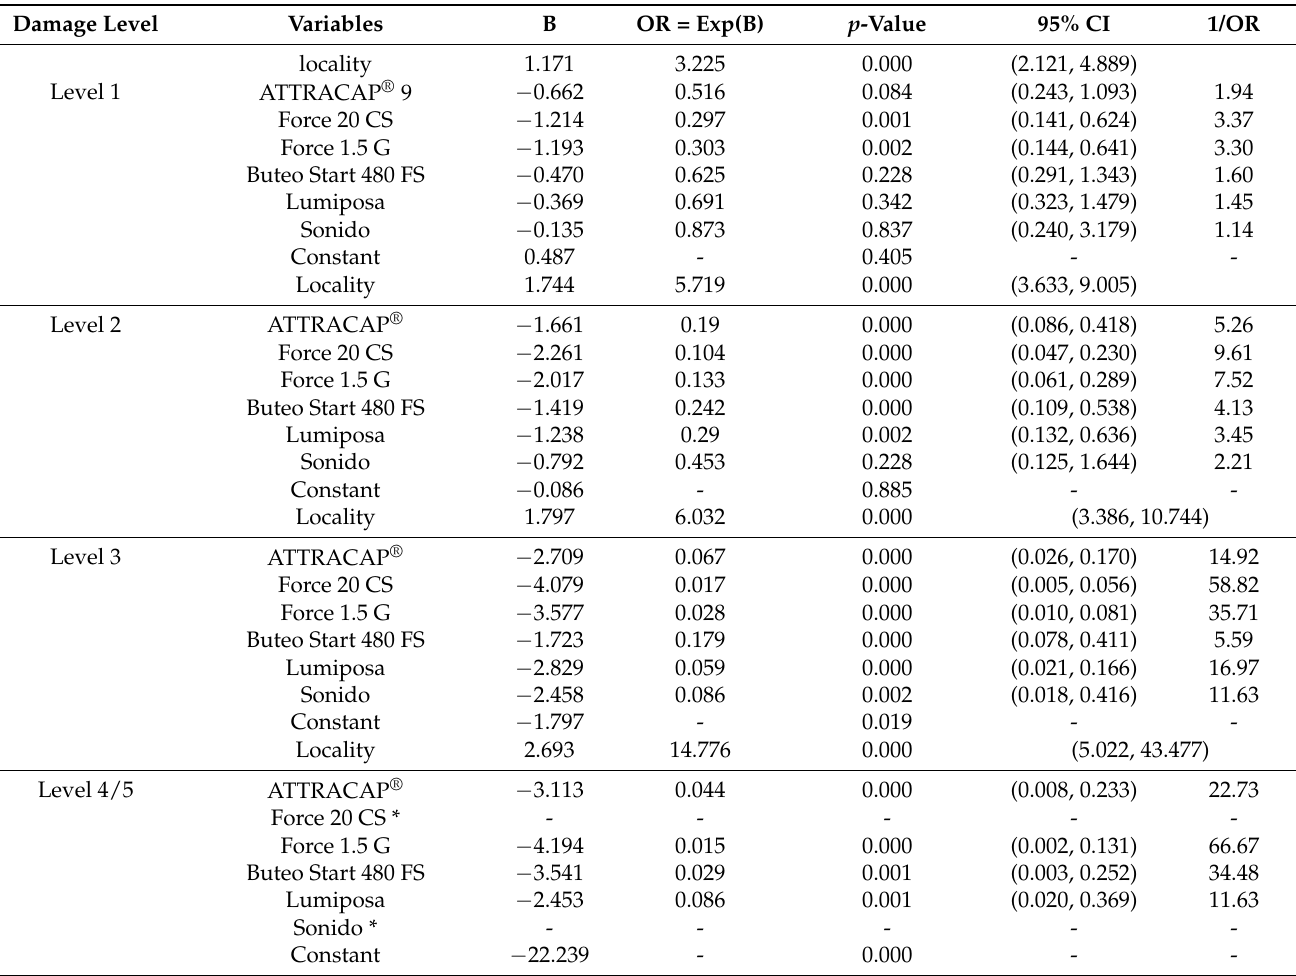
Table 7. Results of the multinomial regression for modelling wireworm damage levels depending on the locality and